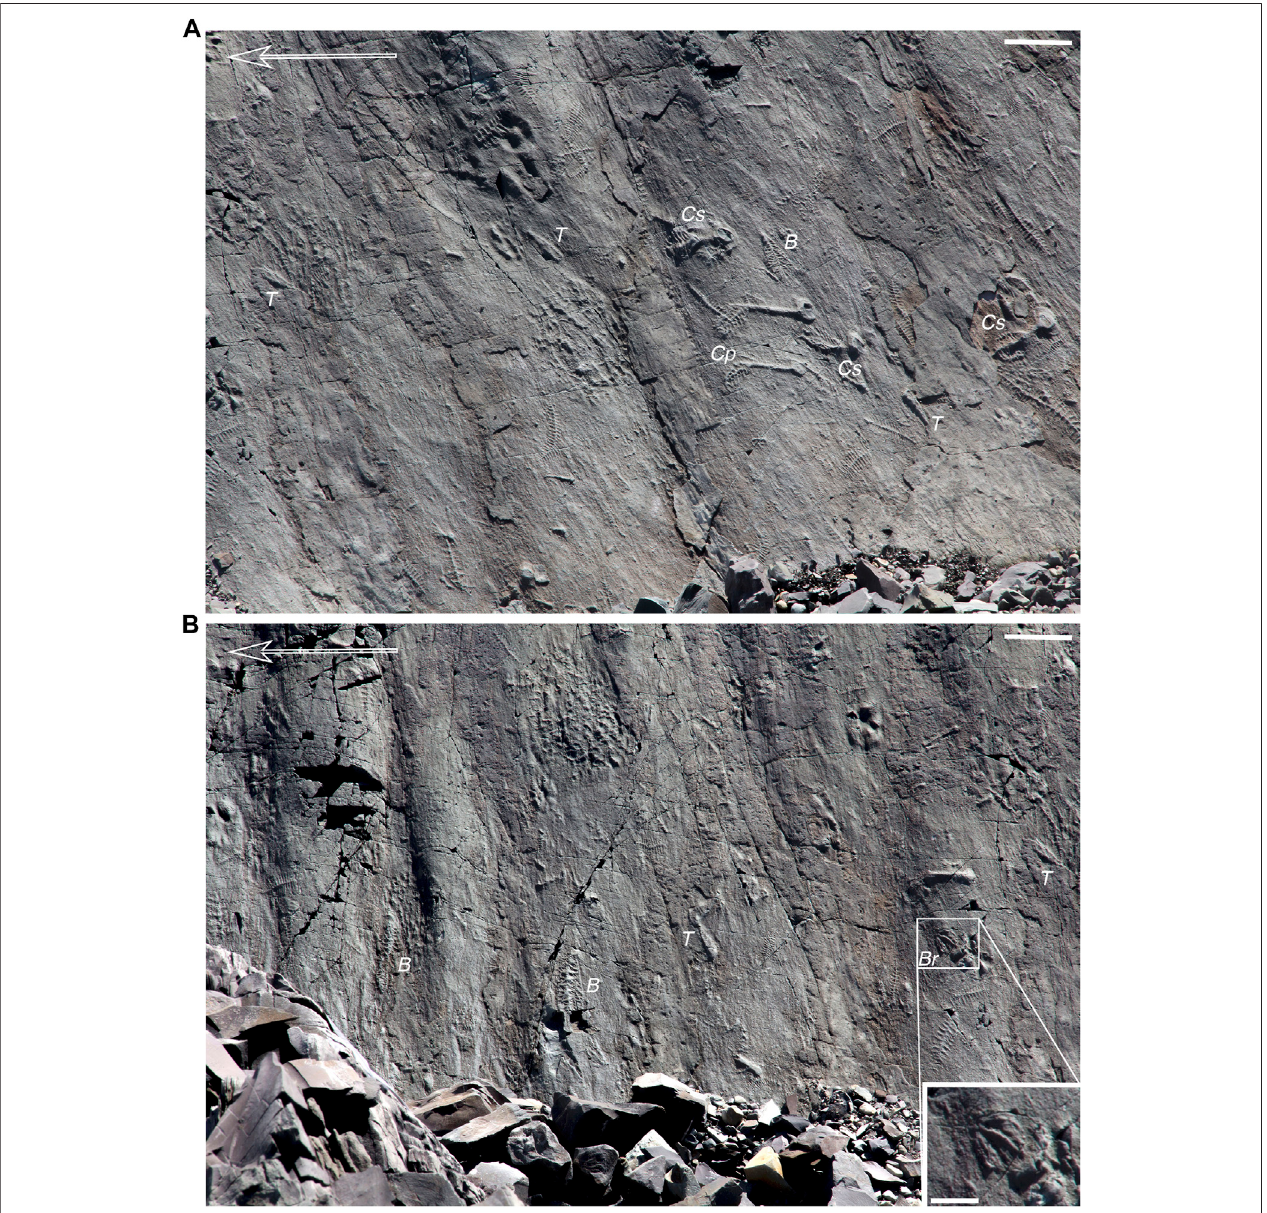
FIGURE 1 | (A) Mistaken Point E Surface immediately surrounding “ Seilacher ’ s Corner, ” including several presumptively current-aligned Charniodiscus fronds ( B , Beothukis ; Cs , Charniodiscus spinosus ; Cp , Charniodiscusprocerus ; T , Thectardis avalonensis );arrow indicates inferred paleocurrentdirection (scale bar =10 cm). (B) MistakenPointESurfaceimmediatelyeastof “ Seilacher ’ sCorner, ” withmultiplealignedspecimensof Beothukis sp.( B )and Thectardisavalonensis ( T )aswellasasingle specimenof Bradgatia ( Br )whichisalignedoppositetoinferredpaleocurrentdirection;arrowindicatesinferredpaleocurrentdirection(scalebar=10 cm). (B) inset, magni fi cation of Bradgatia specimen which is aligned opposite to inferred paleocurrent direction (scale bar = 3 cm).